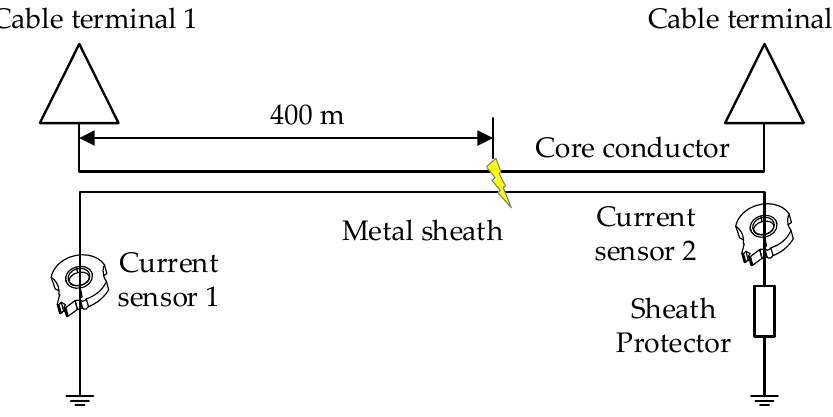
Figure 5. The configuration of a single-point bonding HV cable system.